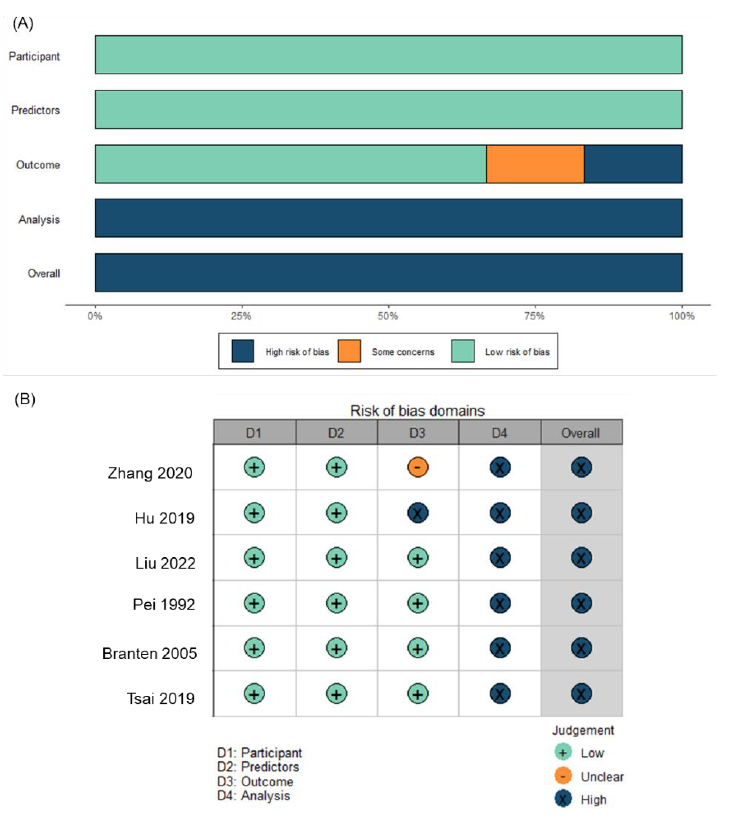
Figure 5. Risk of bias assessment of the six prediction models with renal function deterioration as predicted outcomes. Note: ( A ) Risk of bias summary graph; ( B ) traffic light graph for the risk of bias.